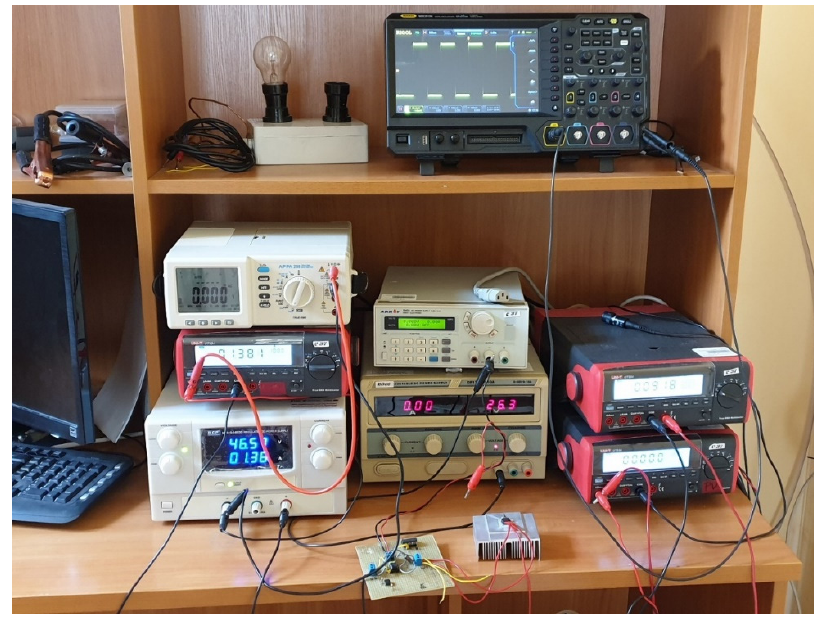
Figure 9. View of the measurement set ‐ up.